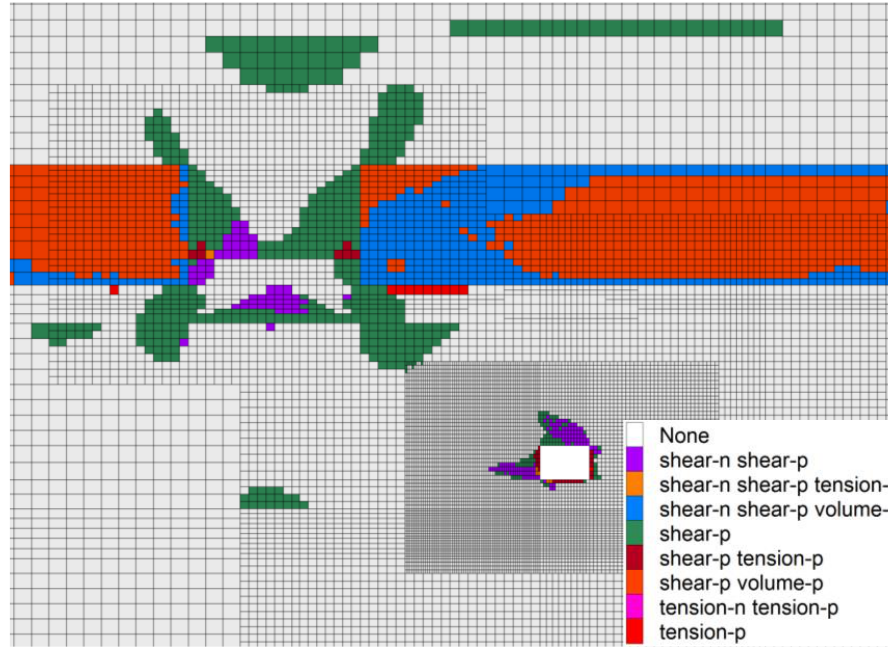
Figure 23. Plastic zone distribution cloud map when the coal column is 15 m.